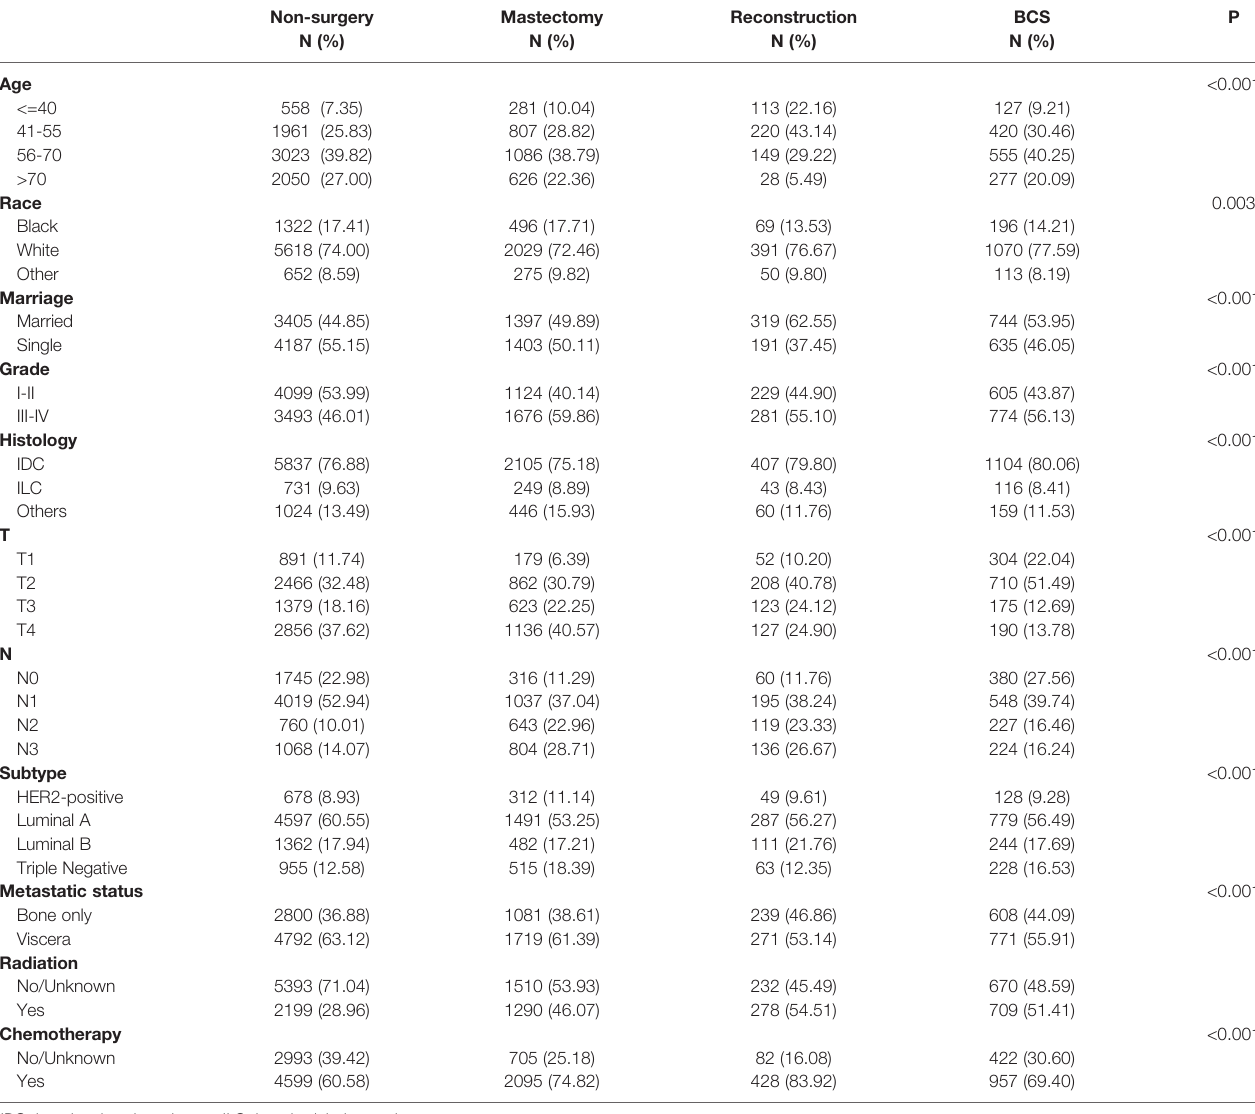
TABLE 1 | The baseline characteristics of de novo stage-IV BC patients with different surgical methods.